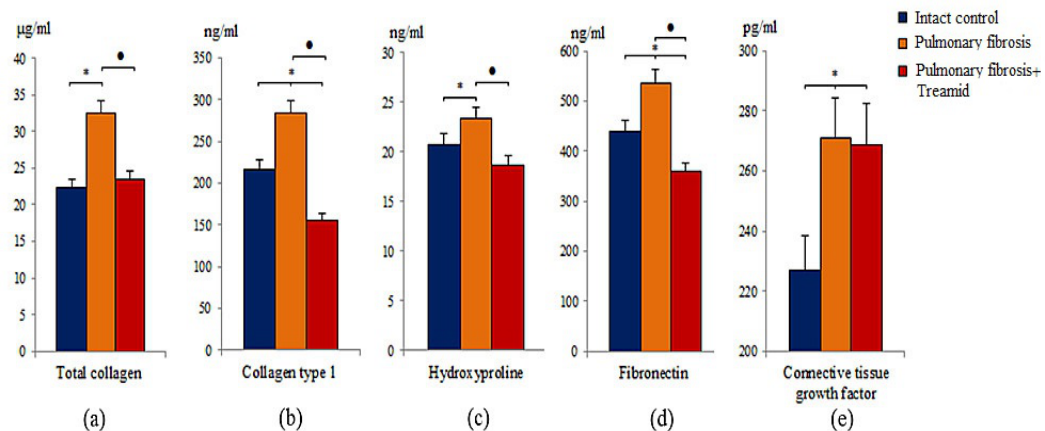
Figure 2. Effects of Treamid treatment on total soluble collagen ( a ), collagen type I ( b ), hydroxyproline ( c ), fibronectin ( d ), and connective tissue growth factor ( e ) levels in homogenate of right lung lobes received from male C57BL/6 mice (d21). Groups: intact control; mice with pulmonary fibrosis (pulmonary fibrosis); mice with pulmonary fibrosis treated Treamid (pulmonary fibrosis+Treamid). * p < 0.05 signi fi cance of di ff erence compared with intact control group, ● p < 0.05 significance of difference compared with the pulmonary fibrosis group.